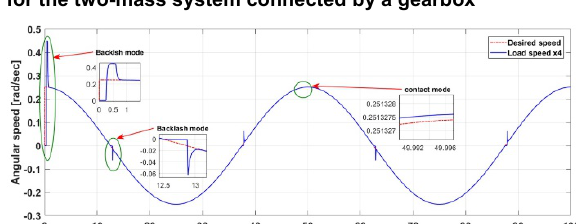
Figure 4. Reference position x d , motor position ( x 1 = θ m ) desired position ( x 3 d ), and load position (( x 3 = θ l ) vs. time for the two-mass system connected by a gearbox